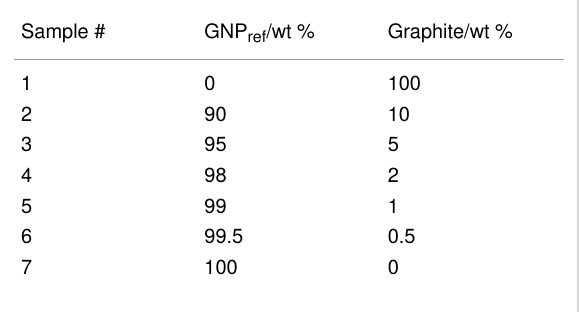
Table 1: Graphite content in the samples measured in this